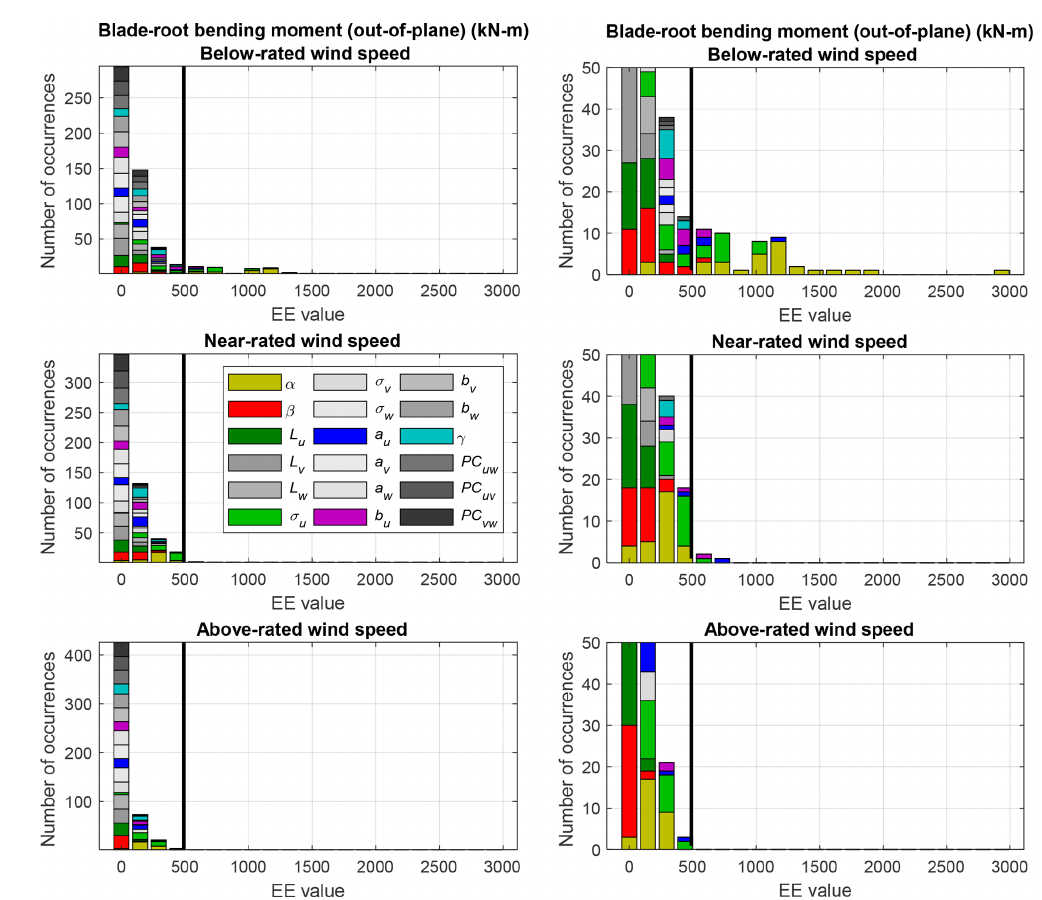
Figure 8. Histograms of fatigue load EE values for the blade-root bending out-of-plane bending moment. Each graph in the left column shows one wind speed bin and includes all input parameters. Right column is a zoomed-in view of the